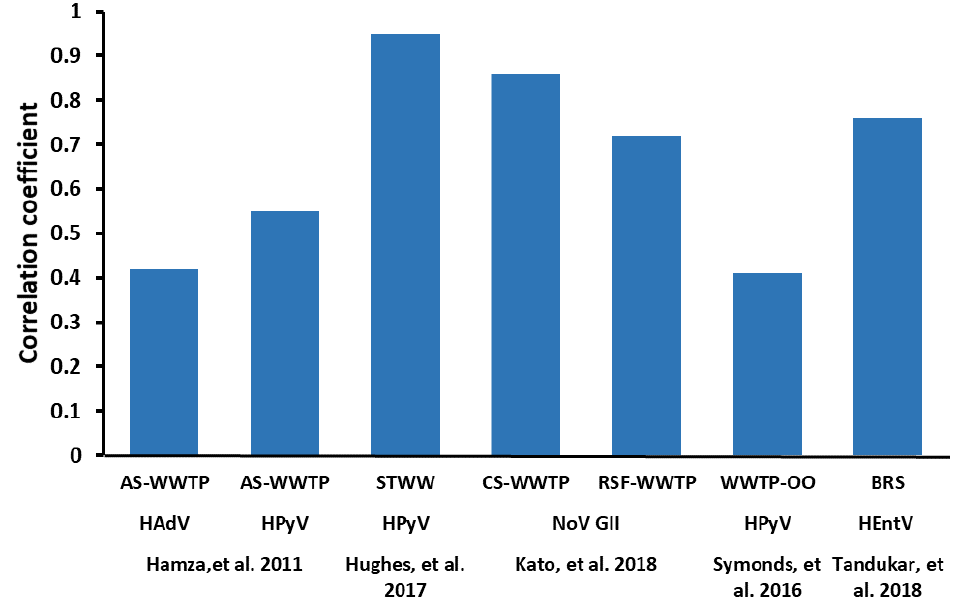
Figure 6. PMMoV correlation to a wide spectrum of water viral pathogens in both WWTPs as well as rivers and oceans [25,152,176,180,186]. AS-WWTP: active sludge-based WWTP, STWW: secondary treated wastewater, CS-WWTP: coagulation–sedimentation-based treatment plant, RSF-WWTP: rapid sand filtration (RSF)-mediated WWTP, WWTP-OO: WWTP ocean outfall, BRS: Bagmati river stream, HPyV: human polyomavirus, HEntV: refers to 8 human enteric viruses cumulatively, including Aichi virus 1, enteroviruses, human cosaviruses, HAdVs, NoV GI and NoV GII, rotaviruses group A and